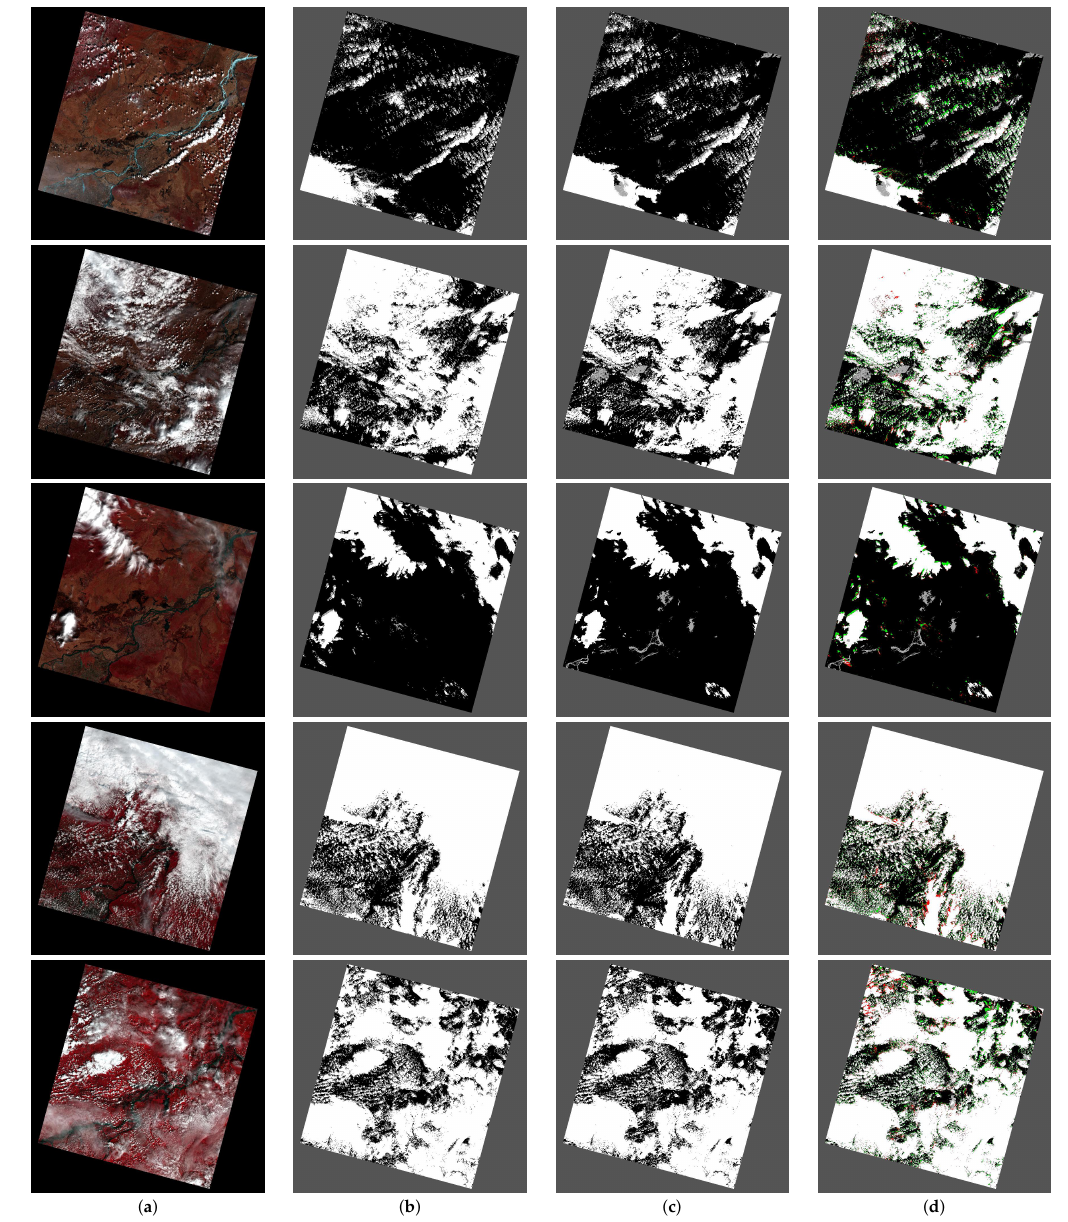
Figure 6. Visualizations of cloud and cloud shadow segmentation (L8, Path 113, Row 26): ( a ) false-color image; ( b ) reference; ( c ) our Refined UNet; and ( d ) differences between references and our results. Bands 5 NIR, 4 Red, and 3 Green are combined together as RGB channels to construct a false-color image for visualization. We mark the differences between clouds by red pixels and shadows by